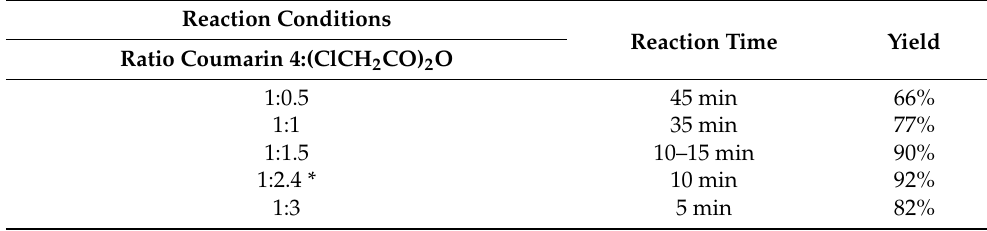
Reaction Time Yield